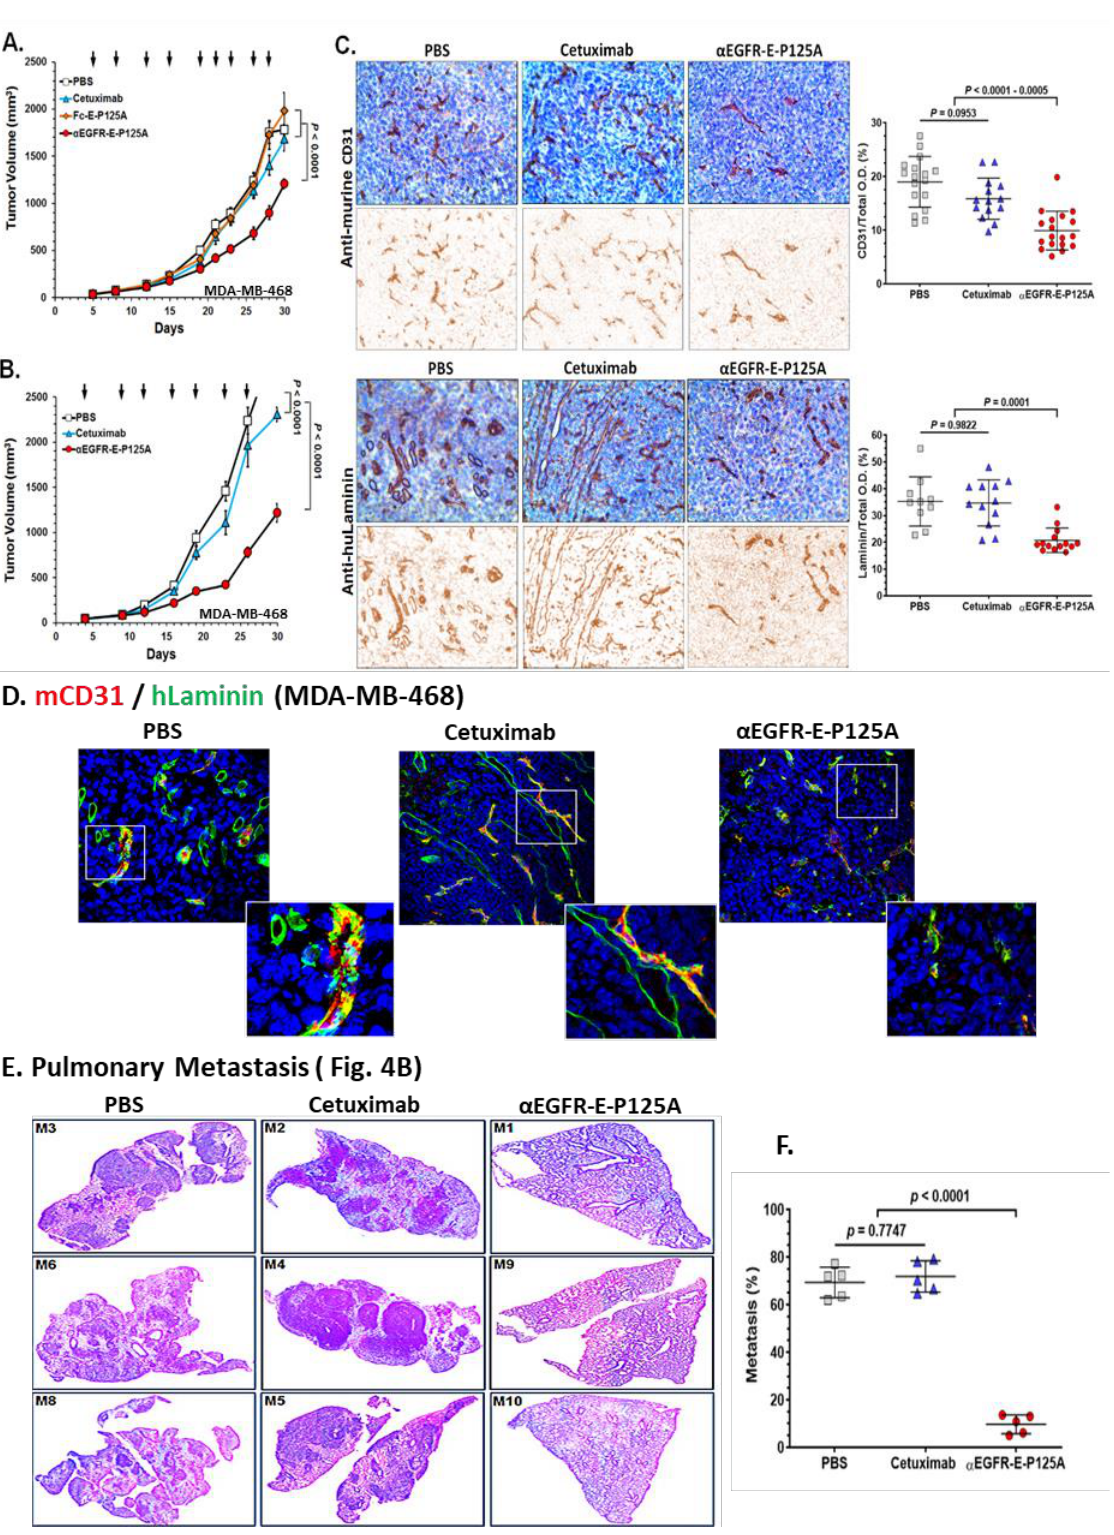
Figure 4. α EGFR-E-P125A effects on angiogenesis, as well as vasculogenic mimicry, tumor growth, and pulmonary metastasis of MDA-MB-468. ( A ) Tumor growth: MDA-MB-468 cells (5 × 10 6 /mouse) were injected into the mammary fat pad (mfp) of female NSG mice ( n = 8). Starting day 5 post tumor implantation, mice were treated with PBS, equimolar cetuximab (170 µ g/injection), Fc-E-P125A (102 µ g/injection), or α EGFR-E-P125A (250 µ g/injection) at the indicated intervals (black arrows). Tumor size assessed by digital calipers. Data are shown as the mean ± SEM. ( B ). Primary tumor growth and pulmonary metastasis: In a separate experiment from Figure 4A, MDA-MB-468 cells (5 × 10 6 /mouse) were implanted in the mammary fat pad (mfp), and mice were treated intravenously starting day 5 post implantation with PBS, cetuximab